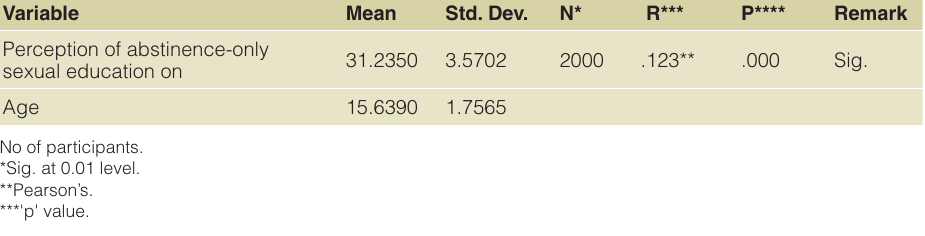
Table 7. Relationship between age and perspective on abstinence-only sexual education. Variable